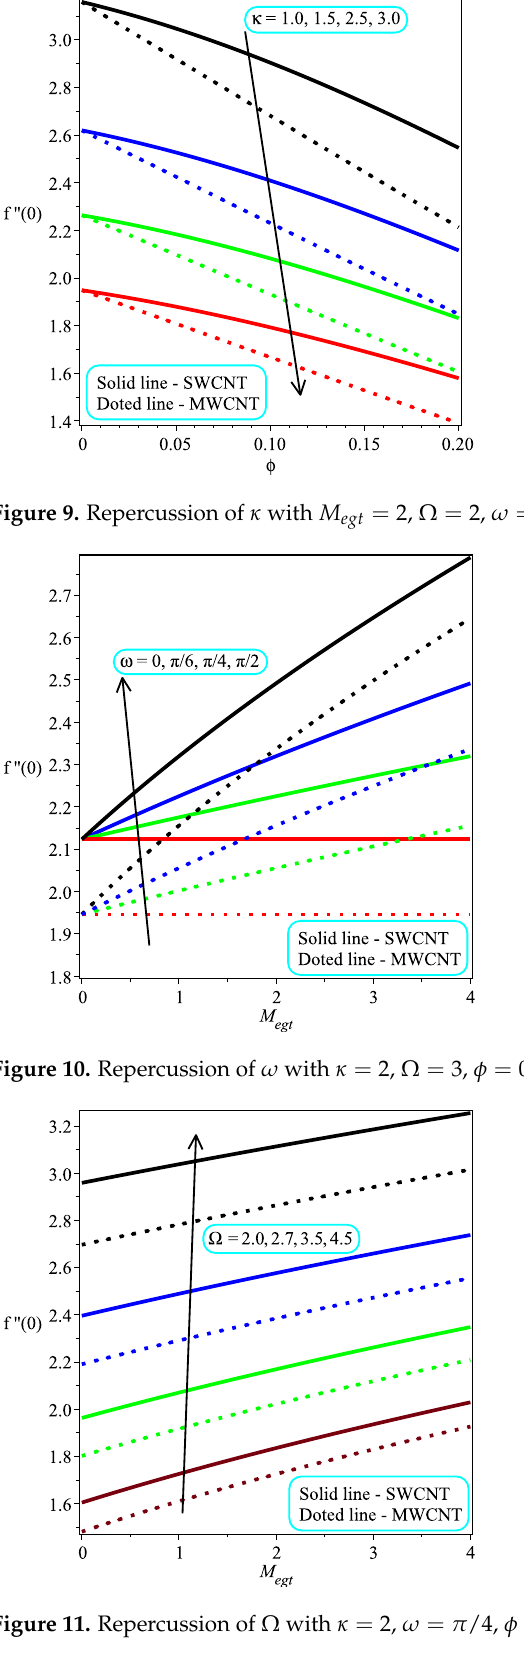
Figure 11. Repercussion of Ω with κ = 2, ω = π /4, φ = 0.1 on the local skin friction